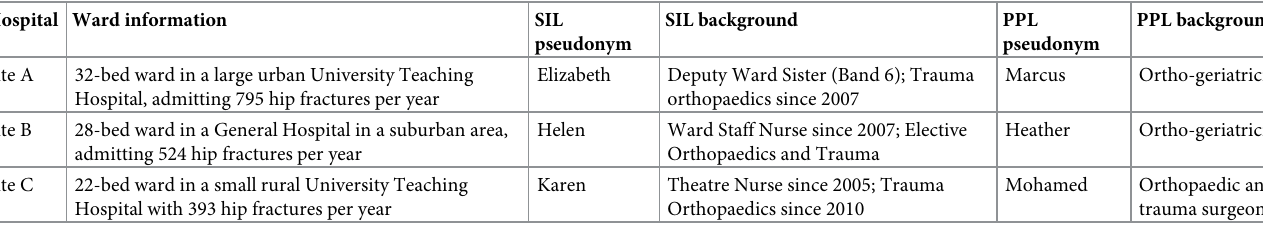
Table 1. SIL and PL